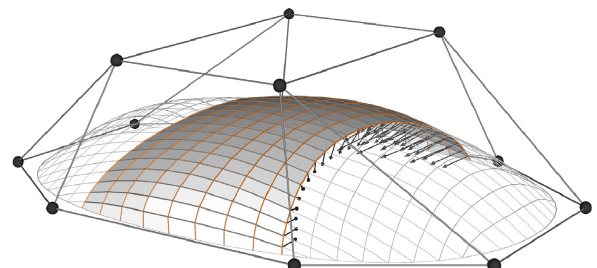
Figure 20: The mesh (the thrust network) resulting from form finding is in force balance with the imposed external